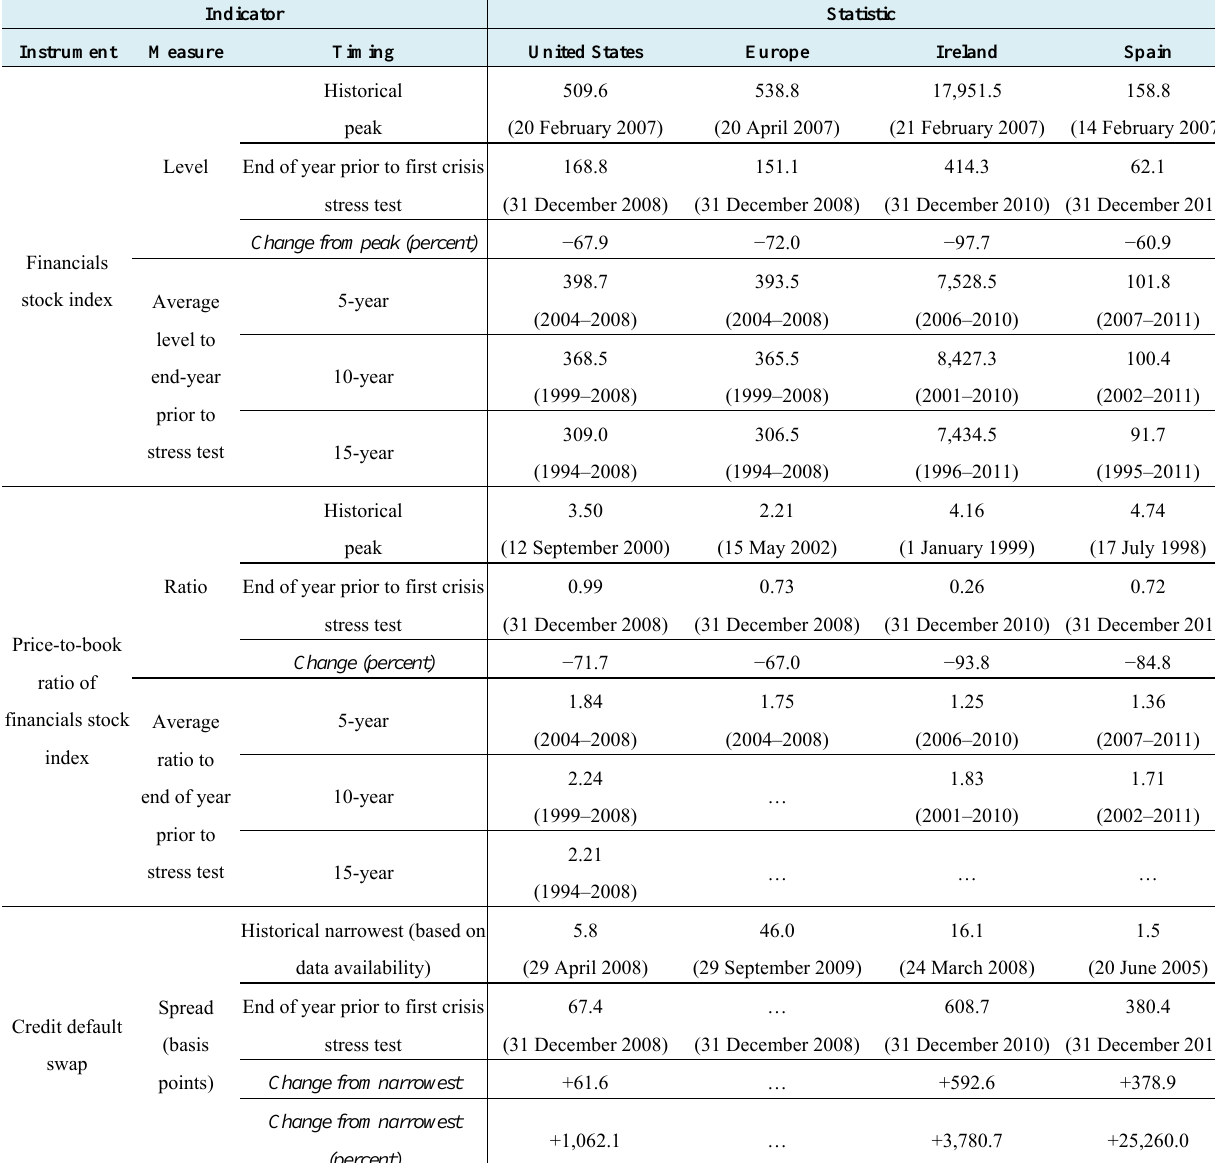
Table 6. Crisis Stress Test Jurisdictions: Financial Markets